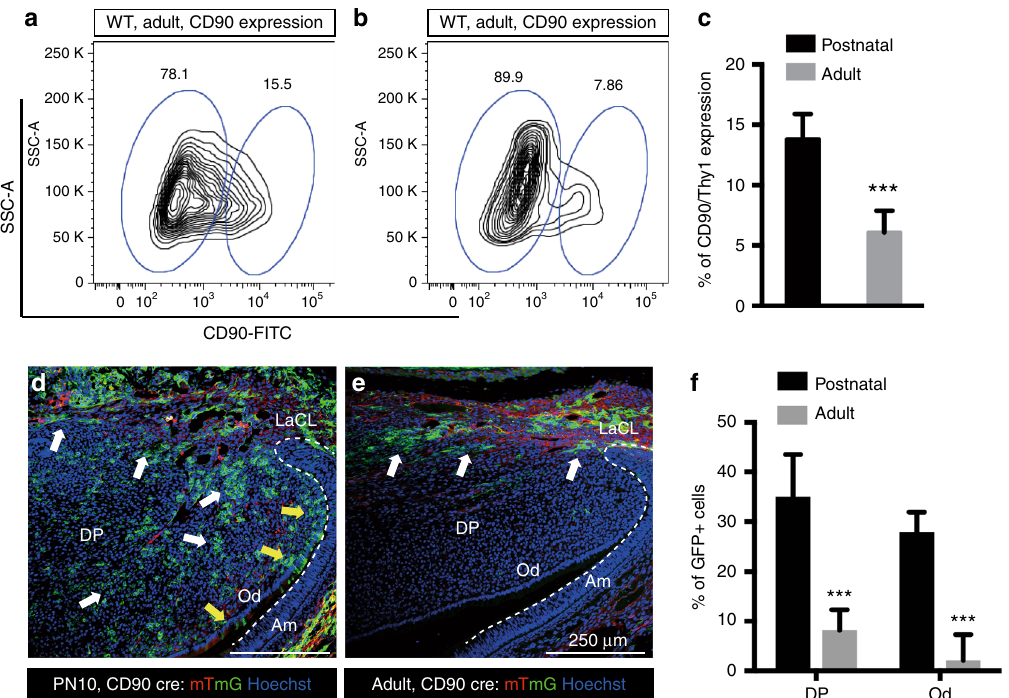
Fig. 3 CD90/Thy1 reduced expression and contribution to the pulp cells and odontoblasts in adult incisors. a , b Flow cytometry data showing CD90/Thy1 expression is greatly reduced in the adult incisor compared to postnatal mice. c Quanti fi cation of CD90/Thy1 expressing cells in the mouse incisor. Data shows a 2 fold decrease in expression in adult incisors compared to postnatal. d , e Lineage tracing of CD90/Thy1 with mTmG reporter identi fi es the dramatic reduction of contribution to the pulp cells and odontoblasts in the adult compared to the advanced postnatal stages. White arrows show pulp cell contribution and yellow arrows show the odontoblast contribution. f Quanti fi cation of CD90/Thy1 contribution to the pulp cells and odontoblasts showing signi fi cantly decreased expression in adults compared with young postnatal mice. N > = 3 mice per group. *** P < 0.001 by Student ’ s t -test. Data presented as mean ±